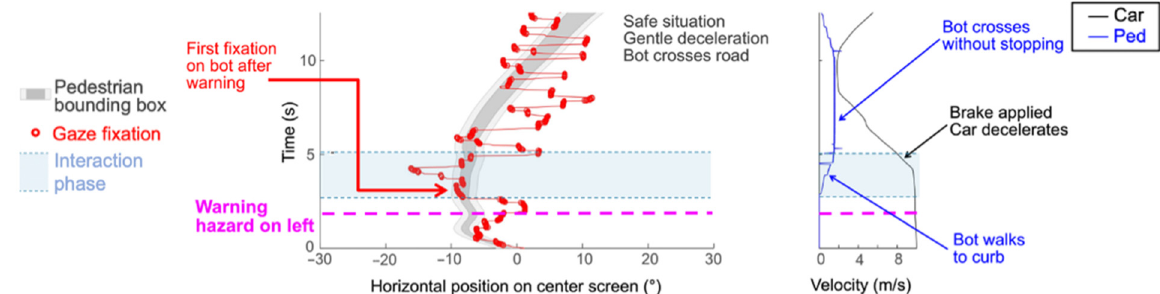
Figure 5. Data for a participant with a left homonymous visual field defect (HVFD) for an event in which a Bot crosses from the left (blind) side of the participant in a drive when the ADAS was engaged. Left panel shows the participant’s gaze behavior (red dots are fixations) and pedestrian position in degrees of visual angle on the center screen of the simulator (dark gray area demarks the outer limits of the bounding box surrounding the pedestrian, the light shading indicates 1 ◦ of visual angle around the bounding box). The pink horizontal line indicates the time of the ADAS trigger, the light blue shaded area indicates the interaction phase. Right panel shows the pedestrian’s velocity (blue line) and the participant’s vehicle velocity (black line) in meters per second (m/s). Soon after the hazard warning, the participant made a gaze movement to the left, which resulted in an early fixation on the Bot and a safe street crossing. The participant decelerated gently, and the Bot crossed the street.